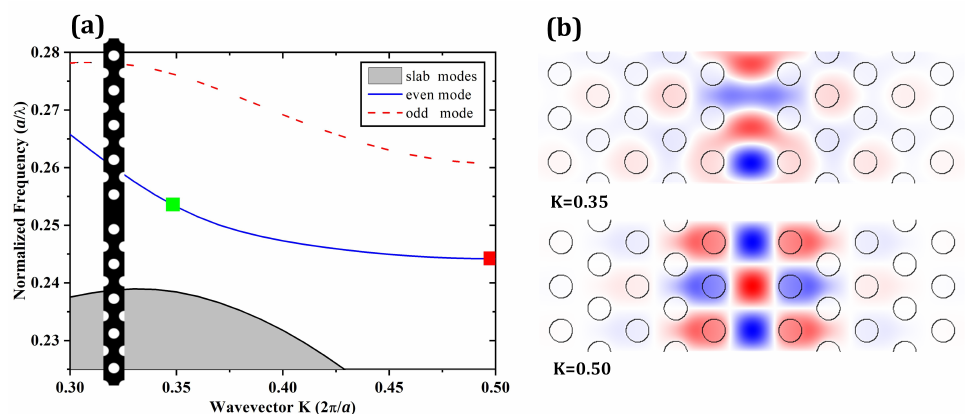
Figure 2. ( a ) Dispersion relationship of the unperturbed standard W1 Si-PhCW, the inset represents the supercell used in MPB, ( b ) Hz field distribution corresponding to TE polarization at K = 0.35 (green diamond in ( a )) and K = 0.5 (red diamond in ( a )),